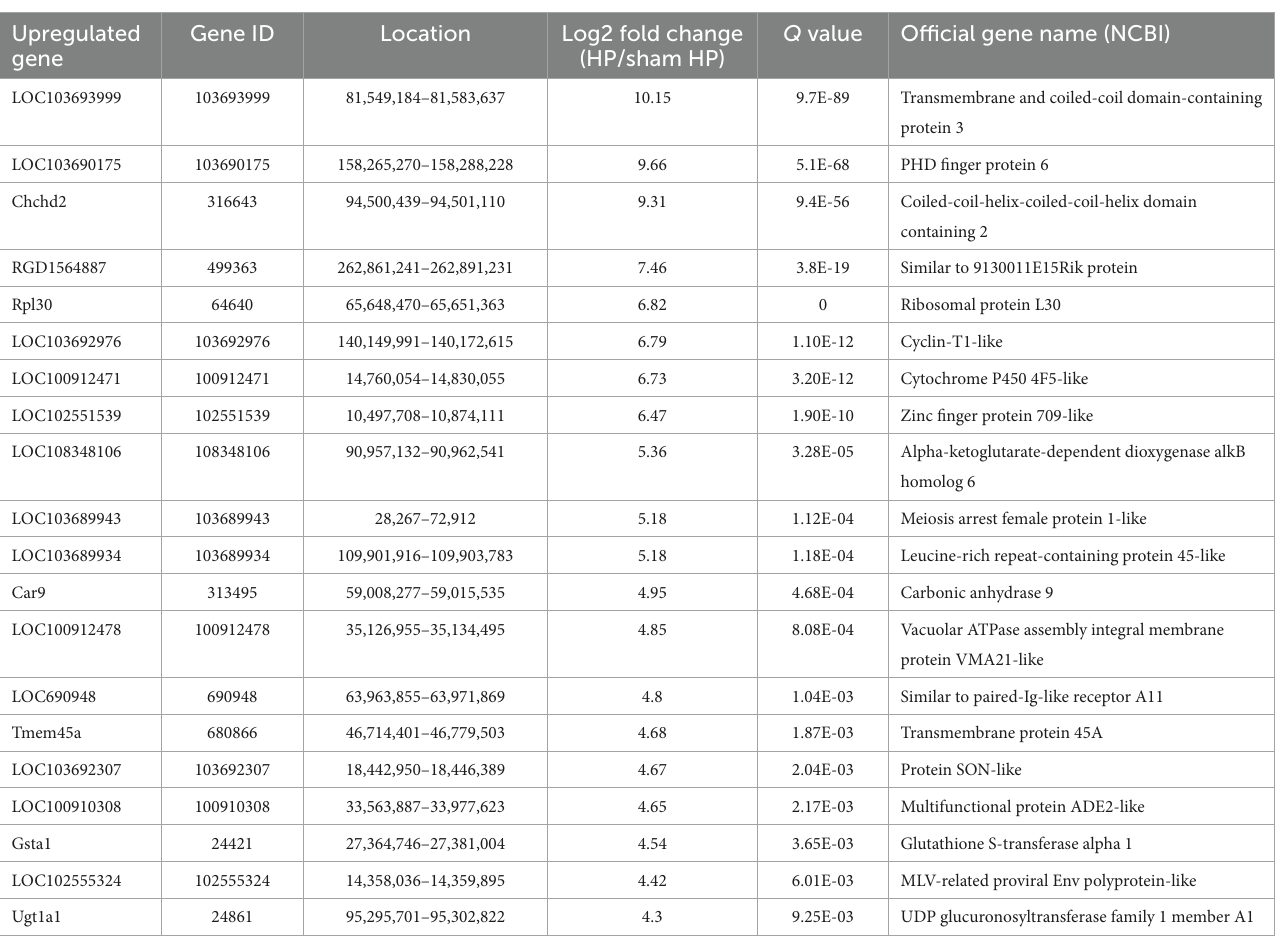
TABLE 3 The top 20 upregulated mRNAs. Upregulated Gene ID gene